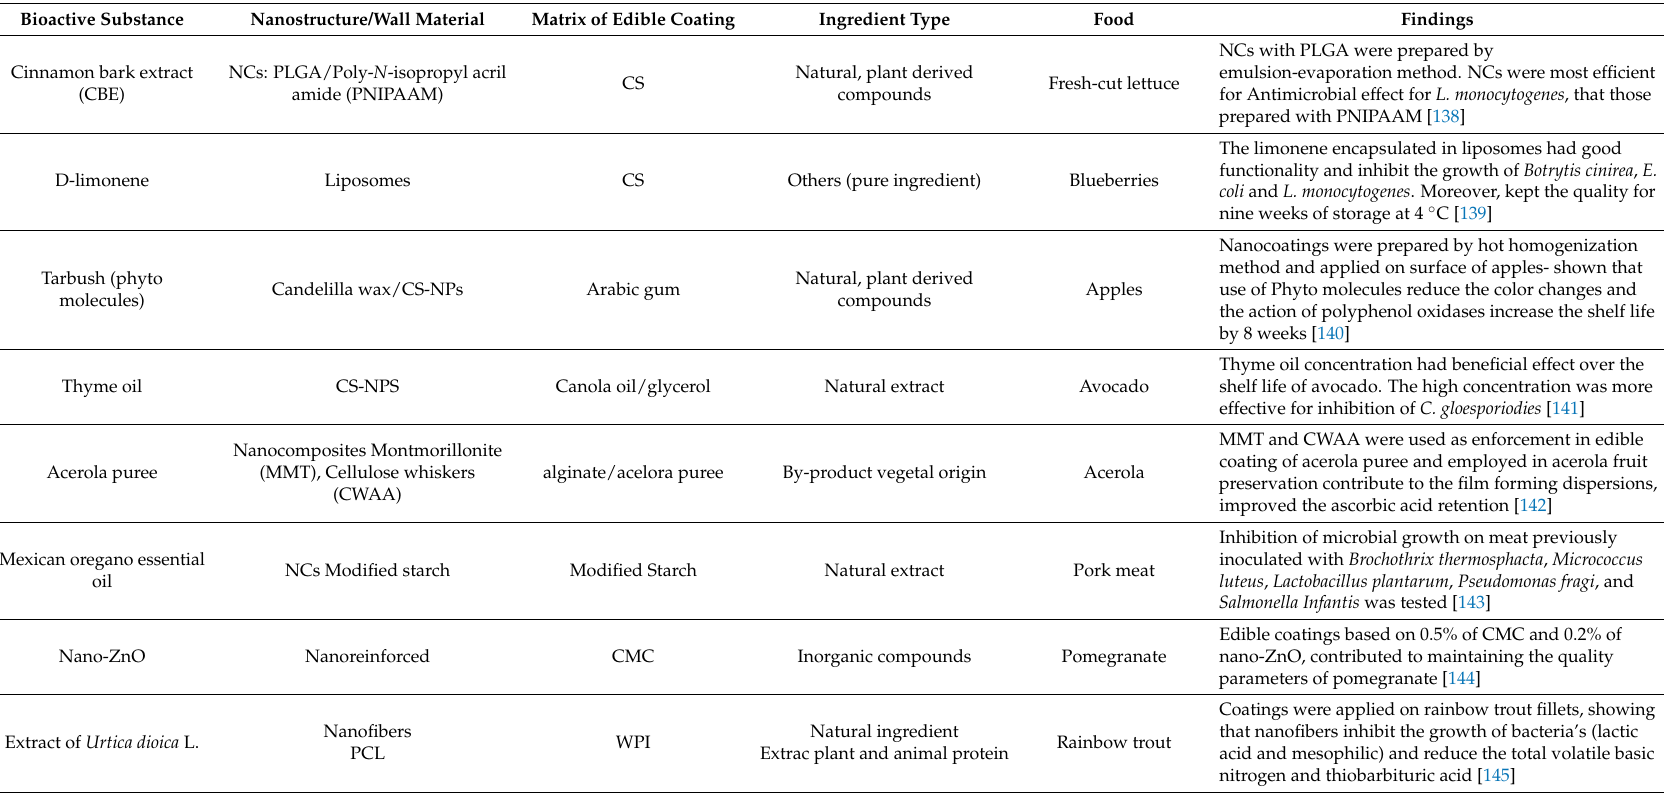
Table 6. Some nanostructures employees in edible coatings for food